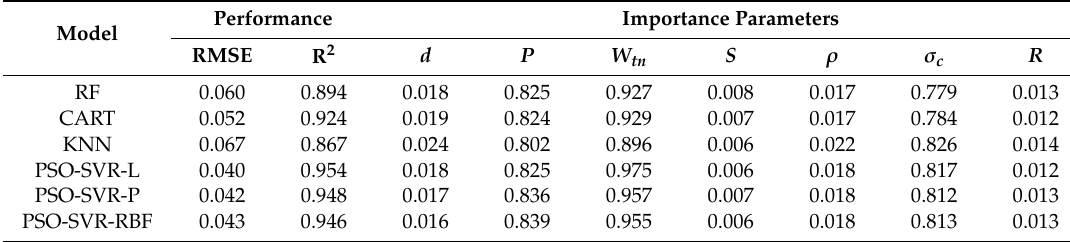
Figure 15. Measured versus predicted values of PM 10 concentration on the testing dataset. Table 6. Important parameters of the models in this